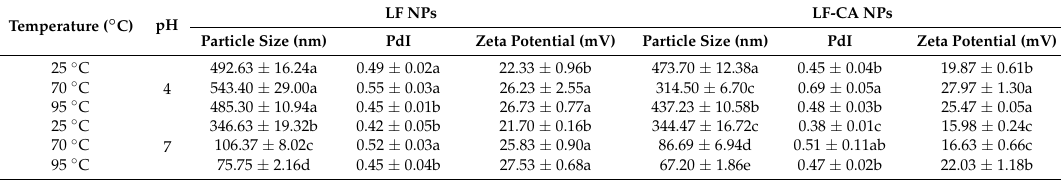
Table 4. Composition and physiochemical characteristics of LF NPs and LF-CA NPs. Different letters (a–e) in the same column indicated significant differences ( p < 0.05).